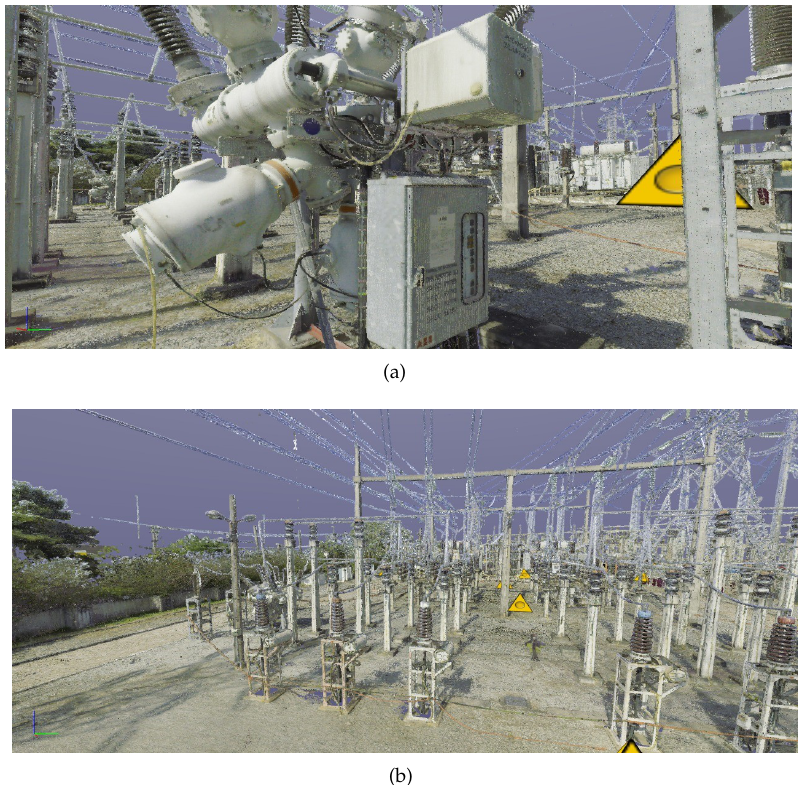
Figure 11. Handheld tool for cloud point data gathering. ( a ) substation asset through point cloud; ( b ) Substation overview through point